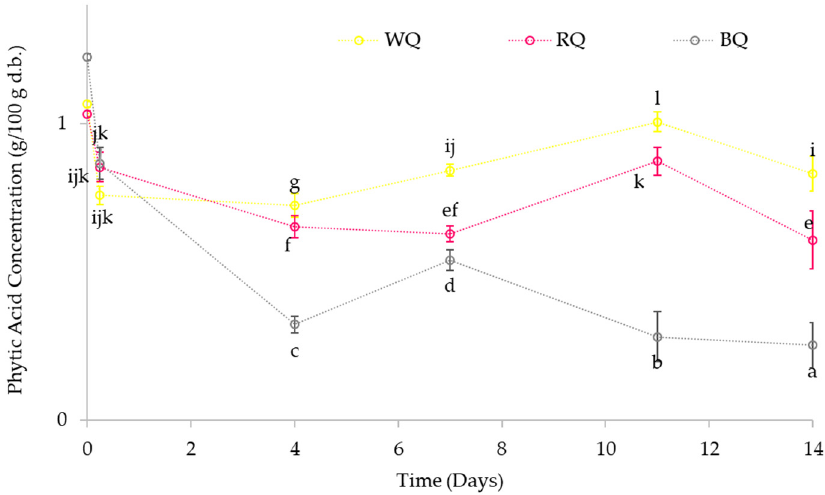
Figure 5. Effect of germination and refrigerated storage on the phytic acid content in three varieties of quinoa: white (WQ), red (RQ), and black (BQ). Error bars indicate standard deviation ( n = 3). Results with different letters are significantly different at p ≤ 0.05.